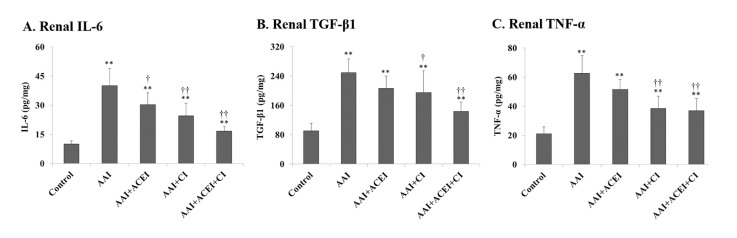
Renal inflammatory cytokine determinations in mice with AAI-induced acute nephropathy.Changes in renal IL-6 (A), TGF-β1 (B) and TNF-α (C) levels were determined. All values are expressed as the means ± SD from each group (n = 9). ** indicates p < 0.01 compared to the Control group; † and †† indicate p < 0.05 and p < 0.01 compared to the AAI group, respectively.